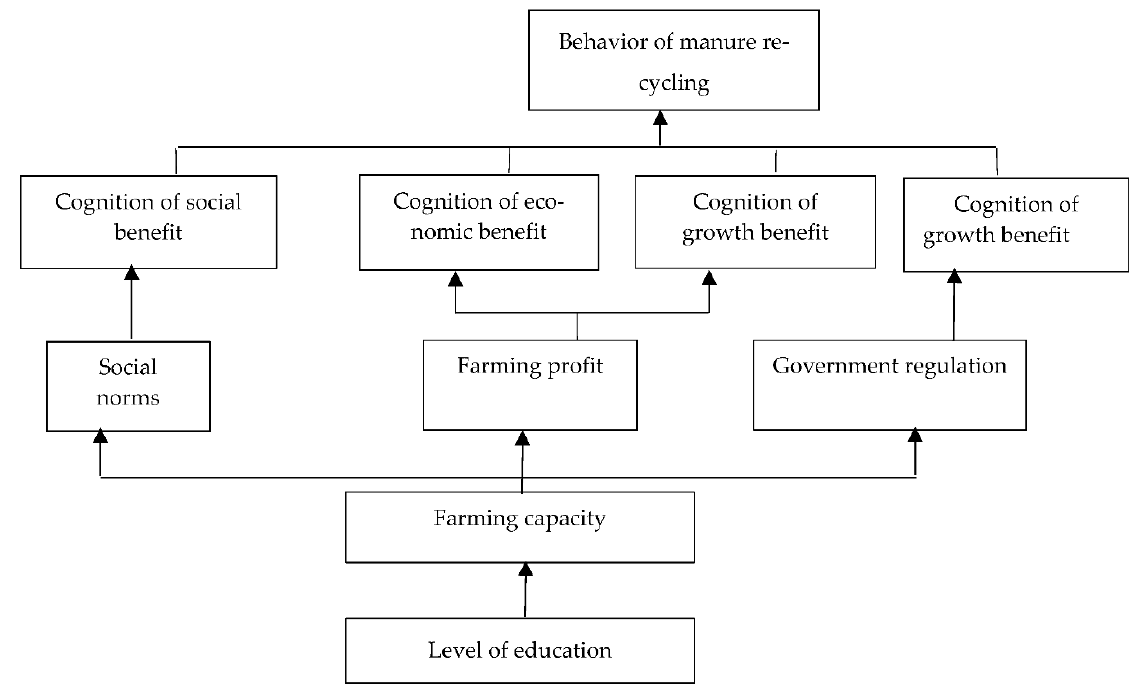
Figure 6. Correlation and Hierarchical Structure Among Influencing Factors of Manure Recycling.